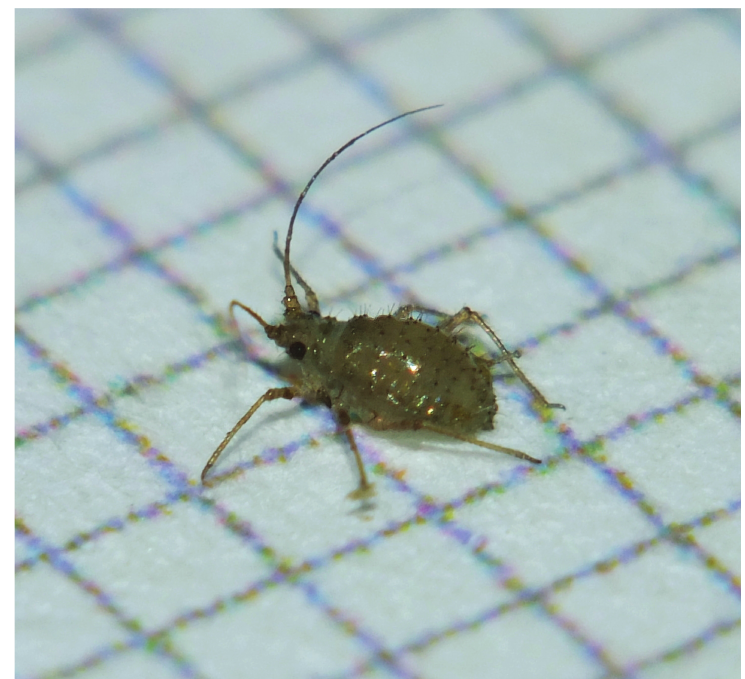
Fig. 10. Cryptaphis poae (hardy, 1850). Apt. from Rhytidiadelphus squarrosus sample. Grid 1